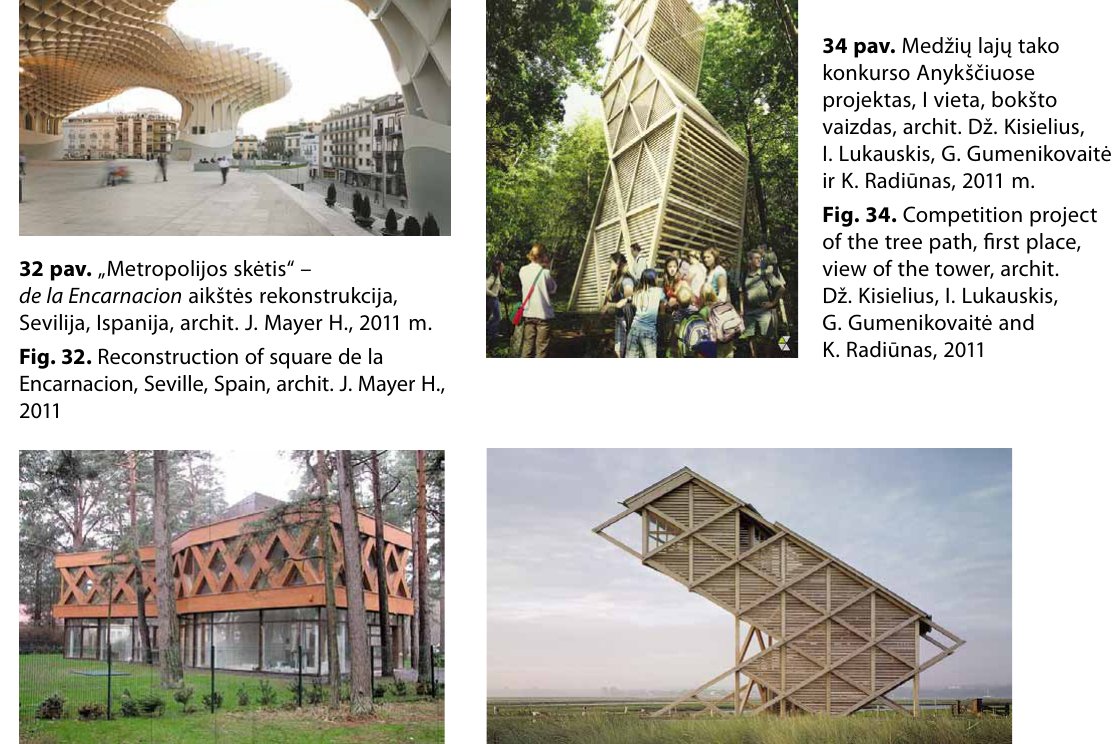
Fig. 35. Birds observation tower in Heiligenhafen,